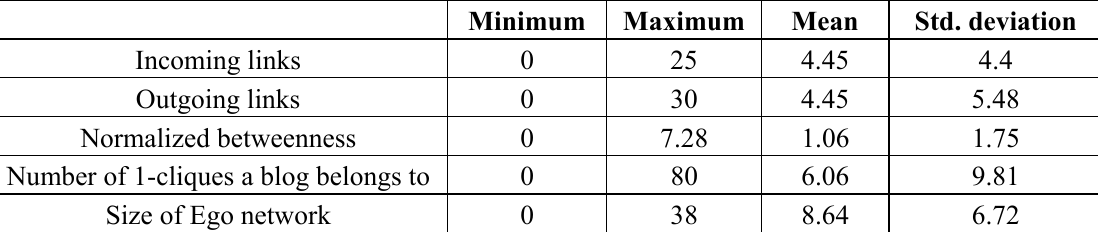
Table 1. Descriptive statistics of the five social network